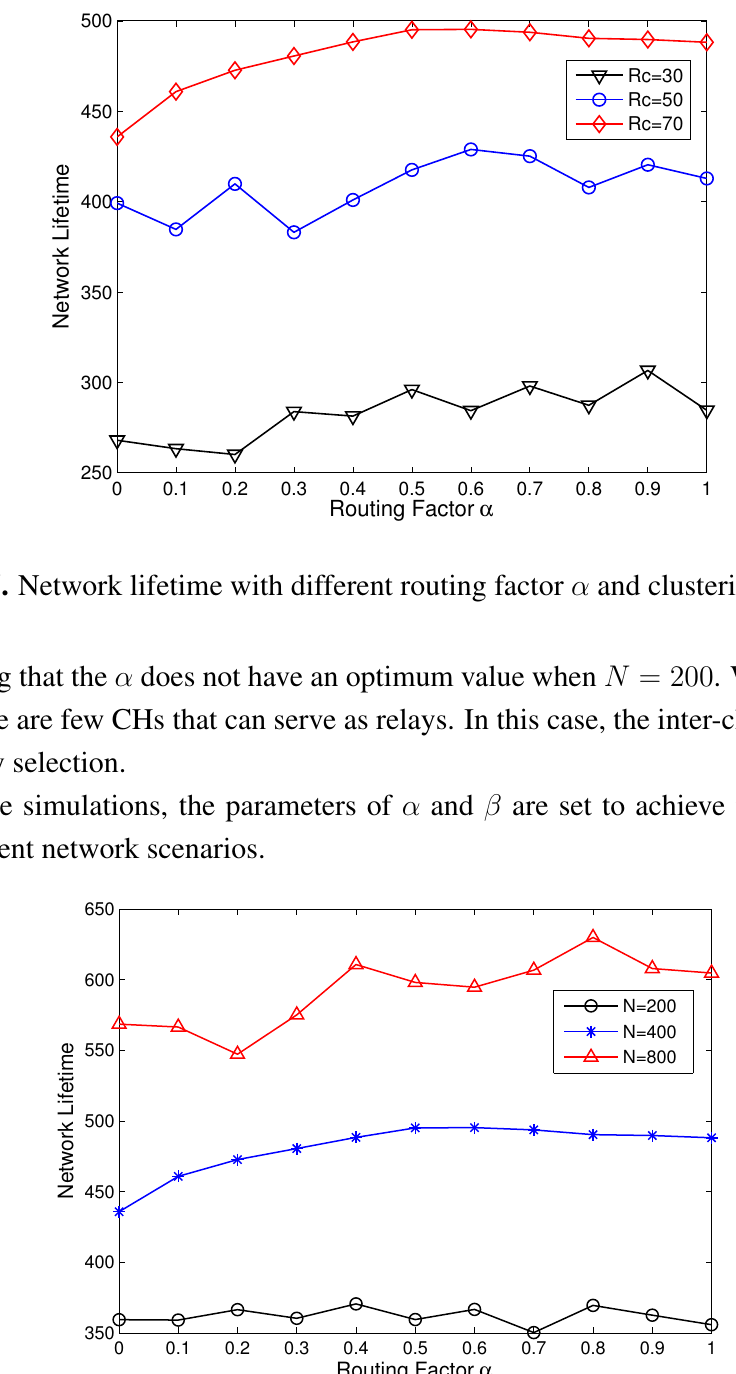
Figure 6. Network lifetime with different routing factor α and node